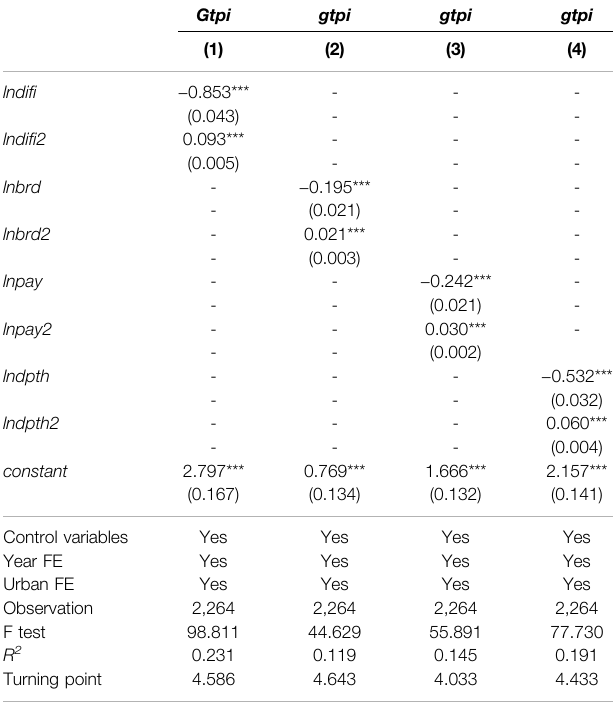
TABLE 5 | Replace the explained